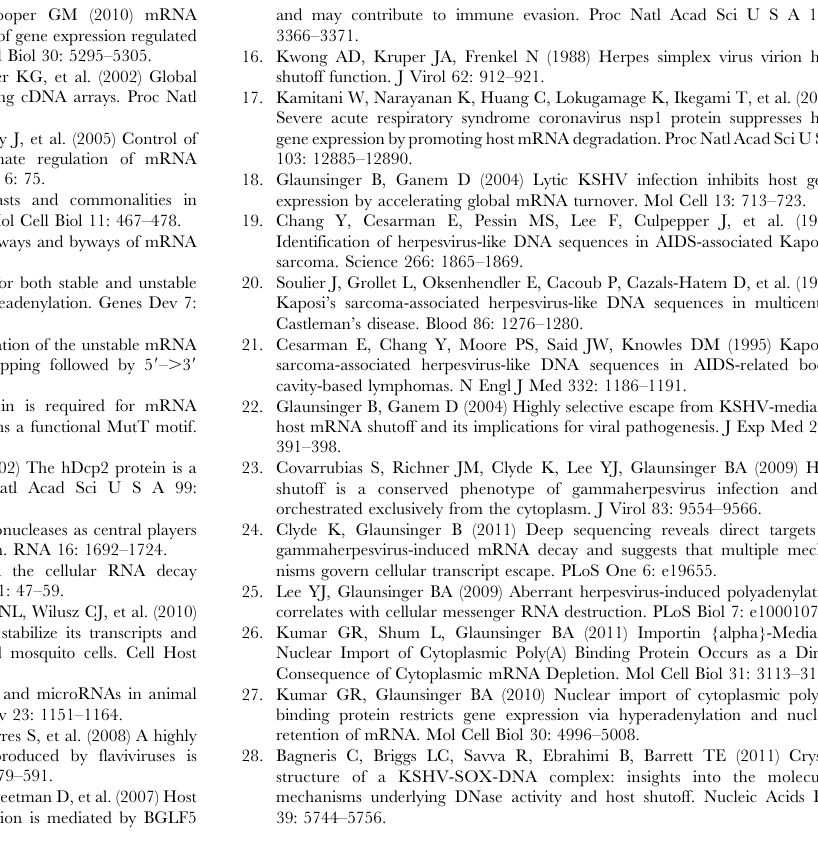
Western blot with indicated antibodies. Figure S6 Evaluation of SOX-induced turnover of translation-defective mRNA constructs. (A) 293T cells were transfected with either normal GFP or a GFP reporter terminating in a hammerhead ribozyme, generating a transcript that is not polyadenylated (GFP-HR; shown in diagram, arrow points at site of ribozyme cleavage). GFP protein expression was assessed by Western blot analysis. Actin was used as a loading control. (B) 293T cells were co-transfected with the normal GFP reporter and GFP-HR with or without SOX. Cells were divided into nuclear and cytoplasmic fractions from which total RNA and protein were extracted. RNA was Northern blotted with a probe annealing to the first 300 bp of the GFP coding region or an 18S probe (upper panels), and protein lysates were Western blotted with a -hnRNP- C1 and a -Hsp90 antibodies to assess the purity of nuclear/ cytoplasmic fractions (lower panels). (C) 293T cells were transfected with increasing amounts (100–300 ng) of GFP or a 5 9 A60-GFP construct containing a stretch of adenosines in the 5 9 UTR (depicted in diagram). Western blot demonstrates a significant reduction in translation of 5 9 A60-GFP. (D) HEK 293T cells were transfected with the 5 9 A60-GFP reporter with or without increasing amounts of SOX (100–300 ng). Total RNA was Northern blotted with GFP probes or 18S probes. (E–F) 293T cells were transfected with either Pol I-driven GFP (E) or Pol III- driven GFP (F) reporter constructs in the absence or presence of SOX. Samples were fractionated into nuclear and cytoplasmic fractions and processed for RNA and protein as described in